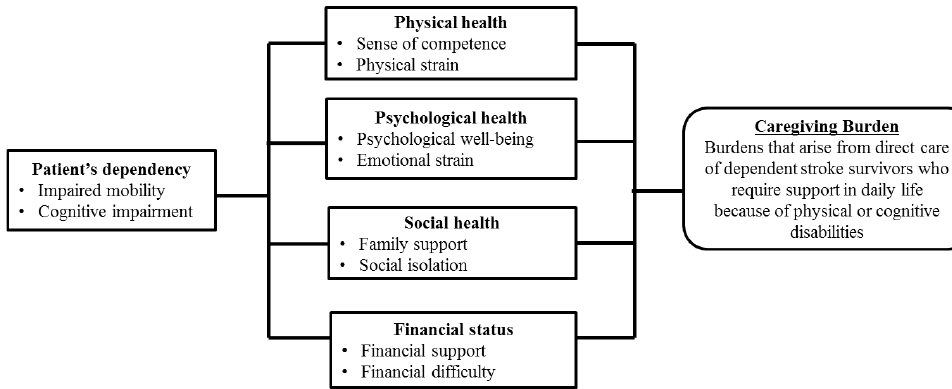
Figure 1. Conceptual framework for caregiving